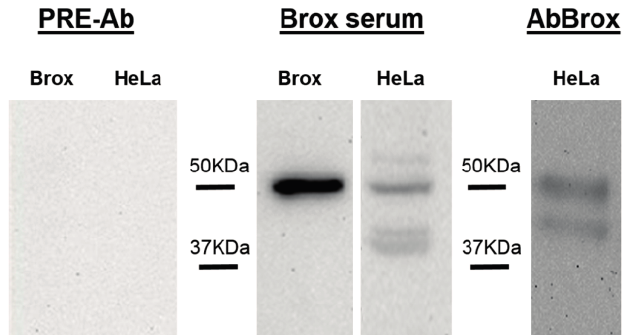
Figure 1. Western blot of HeLa cells lysates and purified recombinant Brox protein (Brox) probed with pre-immune serum (PRE-Ab), Brox serum and purified Brox specific antibodies (AbBrox).